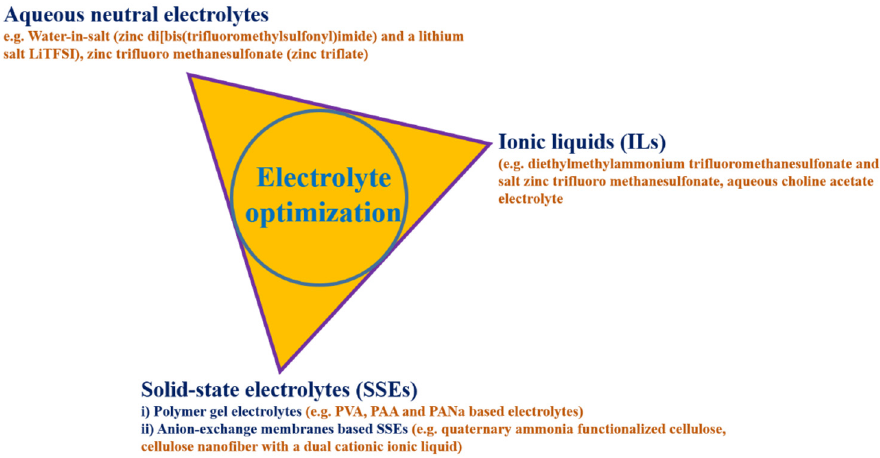
Figure 13. Schematic for recent electrolyte optimization techniques for zinc–air batteries.